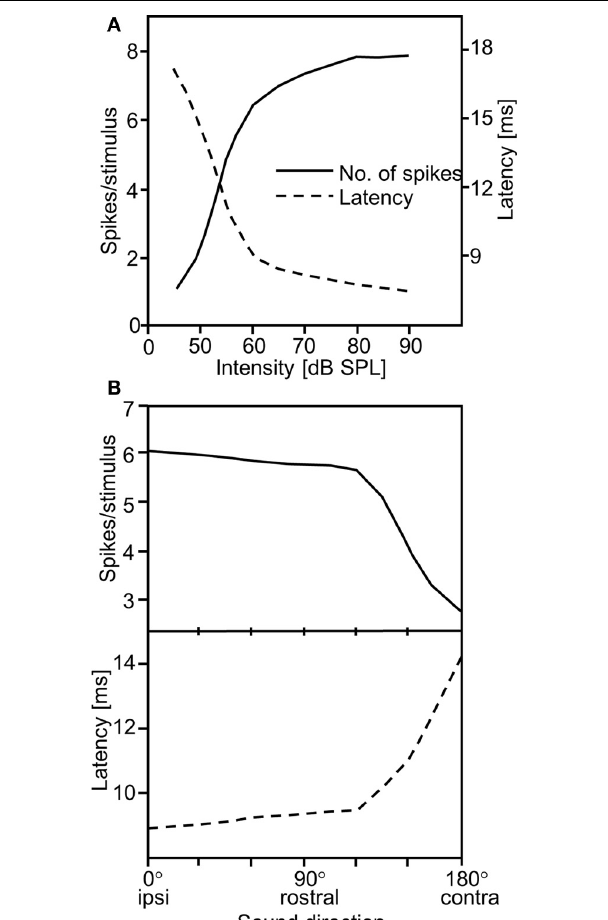
FIGURE 2 | Representative intracellular responses of four different interneurons in the afferent auditory pathway of the locust for sound stimuli presented from their respective ipsilateral, frontal, and contralateral side. Note that all neurons have in common excitatory input from ipsilateral and inhibitory input from contralateral, but that both the timing and the strength of inhibition result in a magnification of either latency differences or spike count differences with changing sound direction (modified from Römer et al., 1981). The arrows indicate the onset of inhibition, which is delayed relative to the excitation in neurons #1 and #2, but is elicited earlier than the excitation in neuron #3 and #4. Stimulus duration: